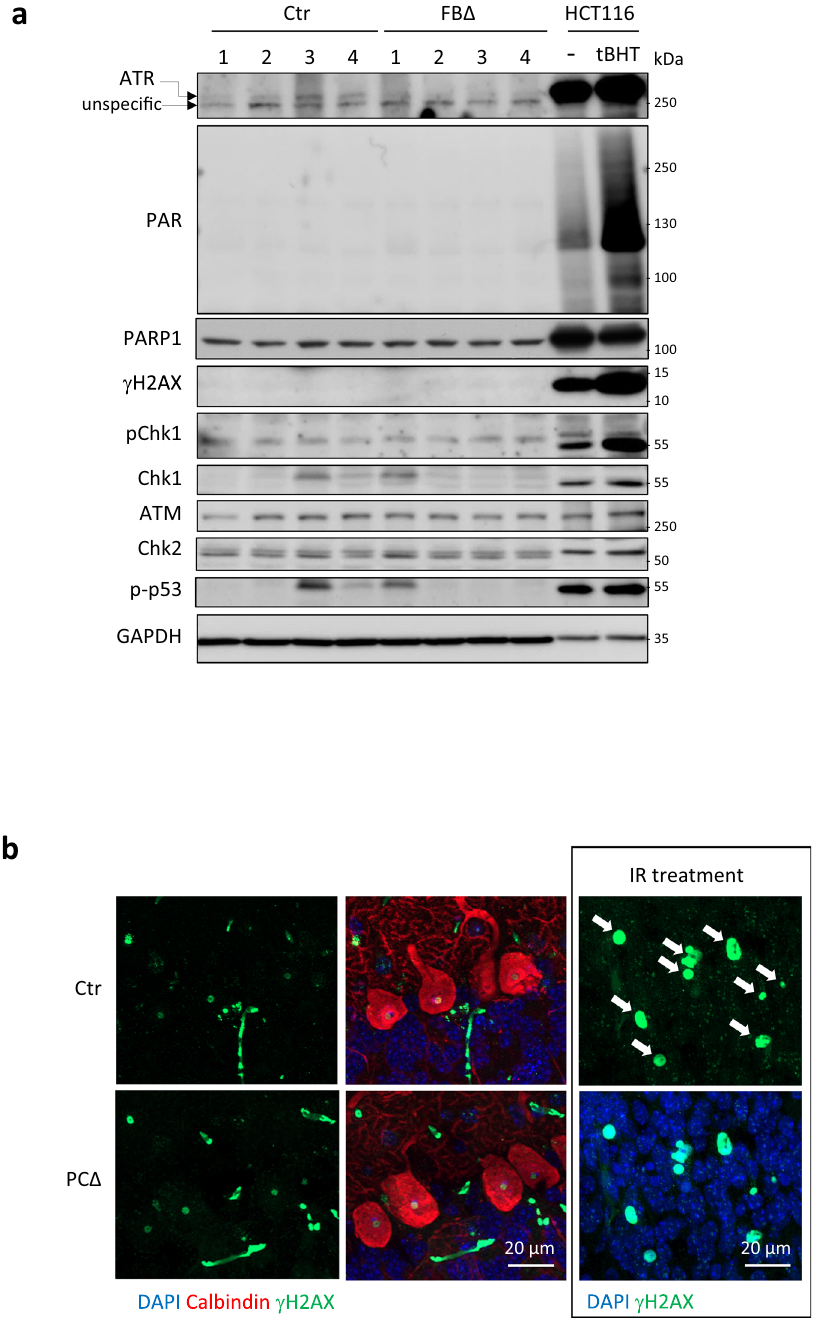
Fig. 7 ATR deletion in neurons does not cause activation of the DDR. a Western blot analysis of the hippocampus of 3-month-old control (Ctr) and ATR- FB Δ (FB Δ ) mice for indicated proteins. The DDR activation is controlled by HCT116 cells without ( − ) or with ( + ) tBHP for 15 min. GAPDH serves as loading control. Four mice (numbers on the top of lanes) of the indicated genotypes were analyzed. b Immunostaining of ATR-PC Δ cerebellum with antibodies against Calbindin (for PCs) and γ H2AX (DNA damage marker, white arrows). The γ H2AX signal is controlled by the cortical sections of mice after 4 Gy ionizing irradiation (IR). The images are representative from 3 to 4 mice per genotype analyzed. Source data are provided as a Source Data fi